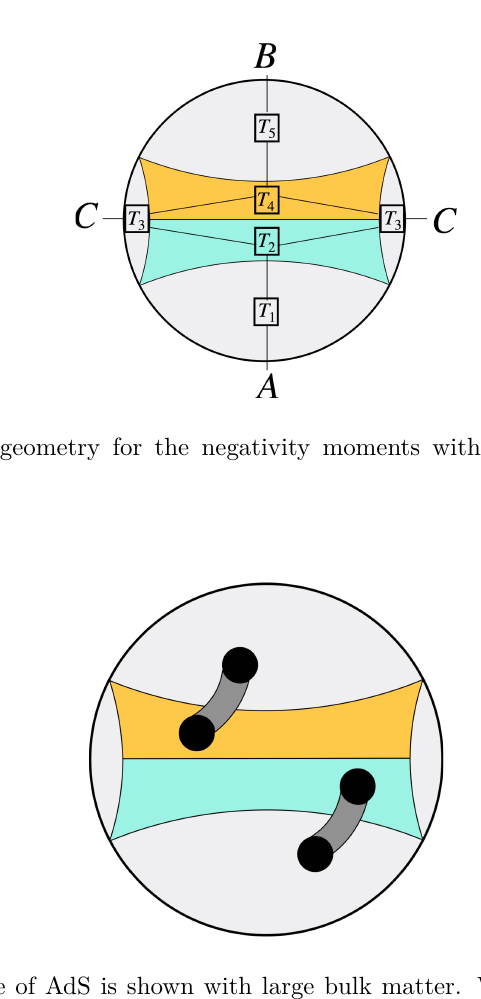
Figure 40 . A time slice of AdS is shown with large bulk matter. We consider highly entangled black holes. The entanglement can geometrically be thought of as a wormhole á la ER = EPR